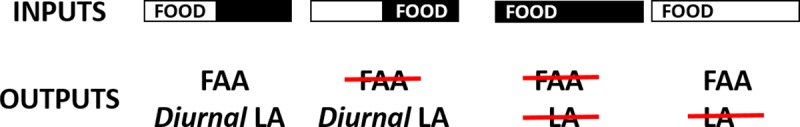
Summary outline from behavior experiments of the inputs regulation (scheduled feeding and light) of the outputs (Locomotor activity (LA) and FAA) in turbot juveniles under laboratory conditions.The rectangle represents the light phase (white) and the dark phase (black) within a period of 24h.